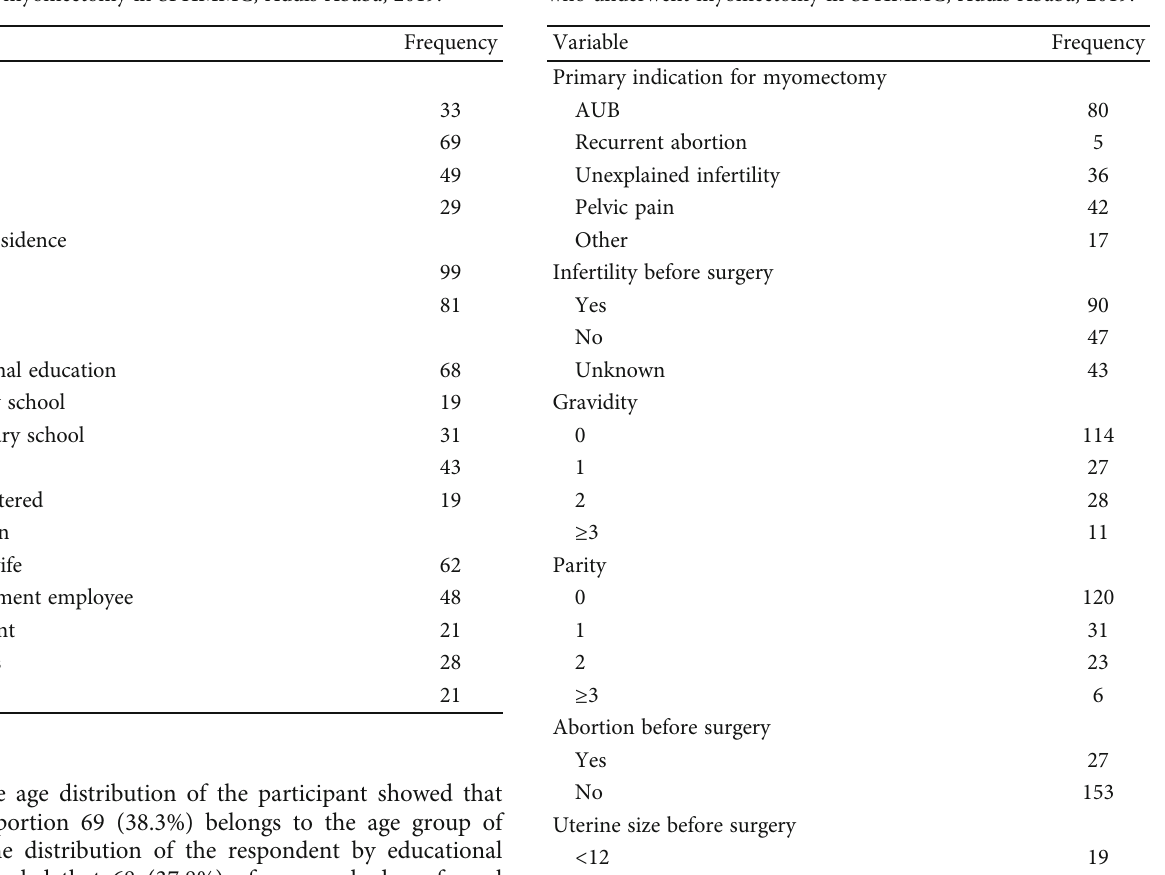
Table 1: Sociodemographic characteristics of women who underwent myomectomy in SPHMMC, Addis Ababa, 2019.